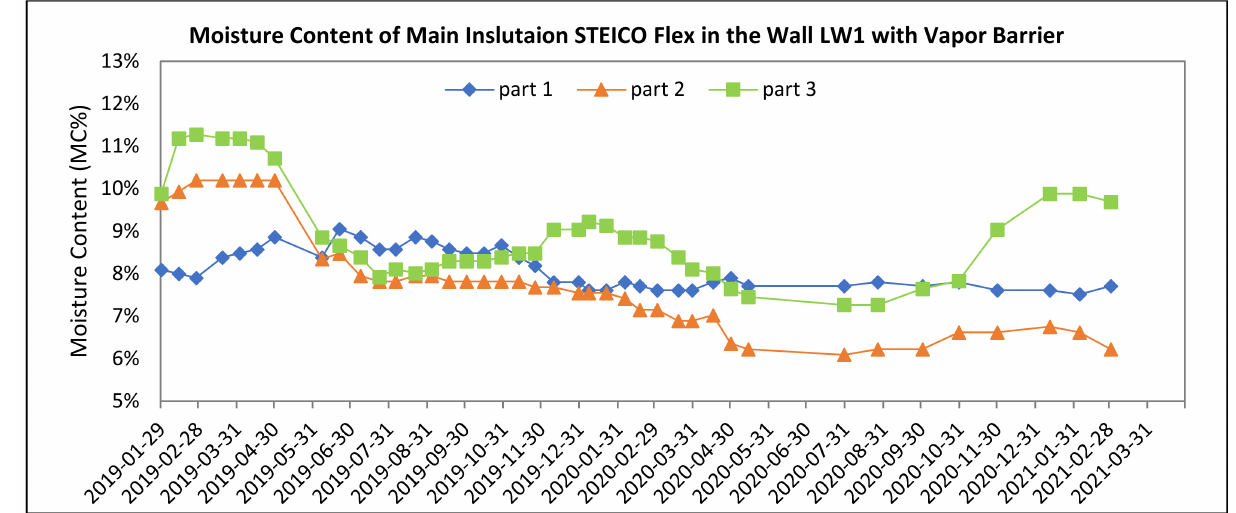
Figure 12. The Moisture Content of the Fiberboard Insulation between Studs in the Wall with Vapor Barrier.